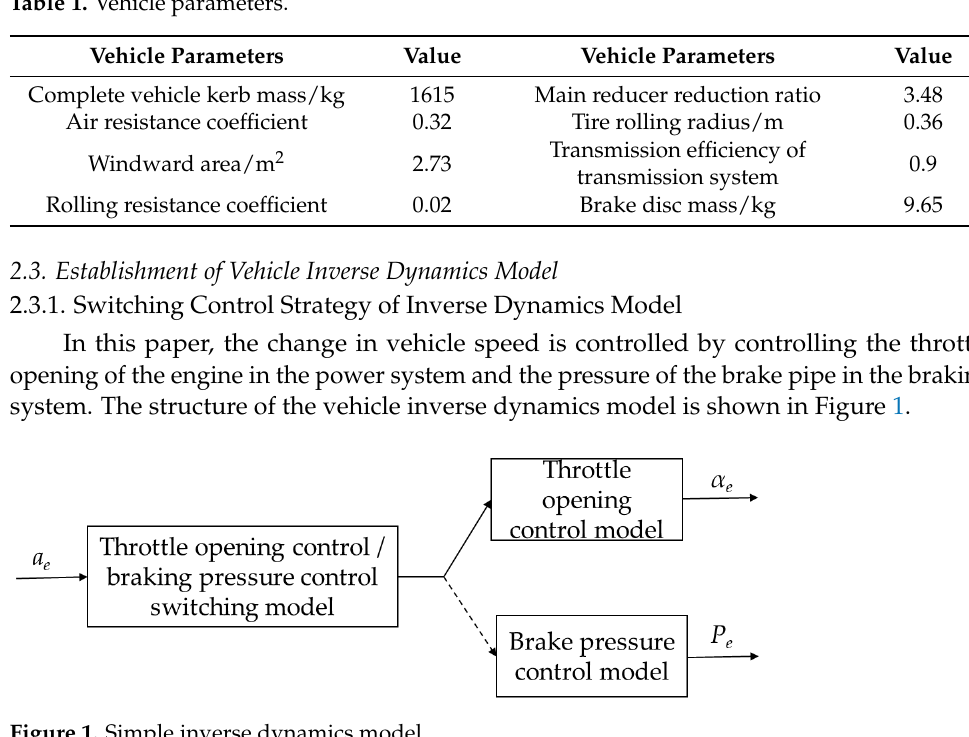
Table 1. Vehicle parameters.